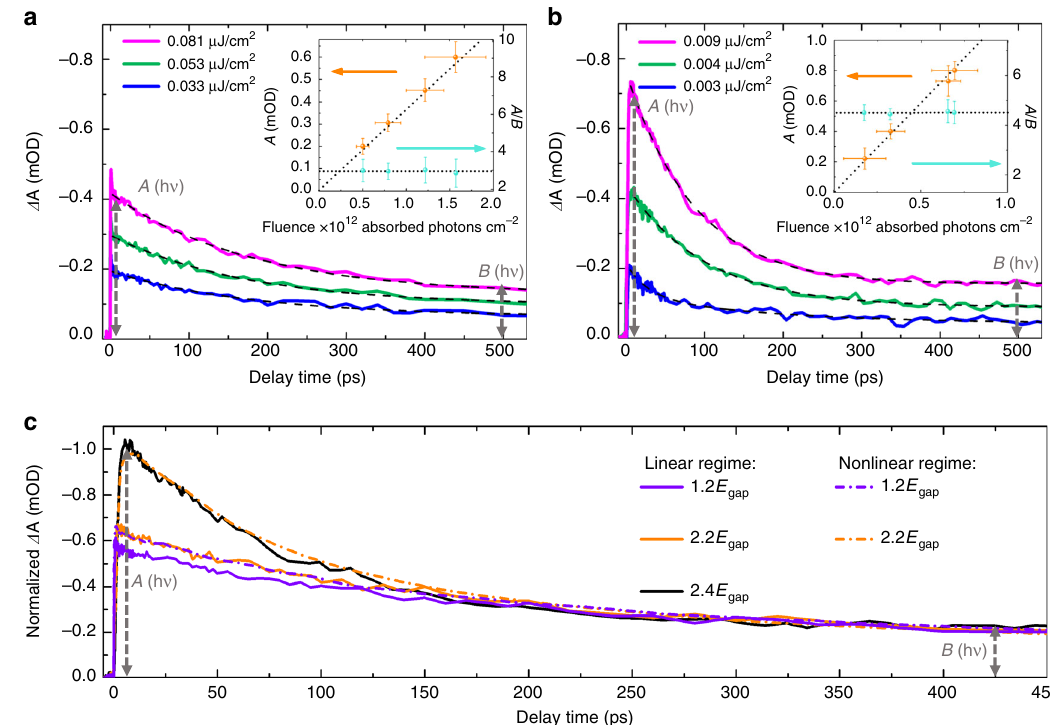
Fig. 3 Transient absorption dynamics. a , b Dynamics below ( a ) and above ( b ) the carrier multiplication (CM) threshold, i.e., at pump wavelengths of 500 nm (2.48 eV) and 295 nm (4.2 eV), respectively. The dashed lines represent the exponential fi t to the data. The appearance of the additional fast component when pumping at 4.2 eV is the fi ngerprint of CM. The insets shows the initial transient amplitude A and its ratio to the single exciton decay tail A / B , as a function of the absorbed photon fl uence, demonstrating the single photon absorption (linear) regime. All dynamics are measured at probe wavelengths around the photo-induced bleach maximum (680 nm) by integrating the signal from 675 to 685 nm. The latter determines the error bars in the y -direction. The error in the x -direction arises from small fl uctuations in the pump power. c Linear vs. nonlinear regime, showing the decay through Auger recombination with pumping outside the linear regime (i.e., by multi-photon absorption) and through CM, yields the same